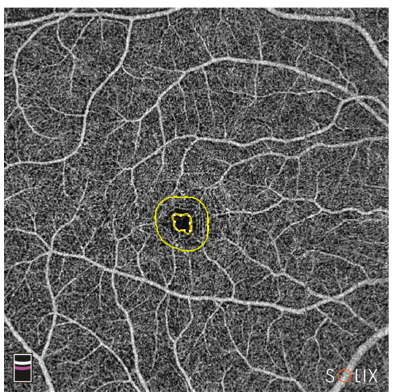
Figure 3. Overview of the optical coherence tomography angiography (OCTA) centered on the fovea. Retinal layer segmentation was automatically performed using the OCTA device and manually reviewed and corrected where necessary. ( A ) En-face image of superficial capillary plexus (SCP) ( B ) En-face image of deep capillary plexus (DCP) ( C ) Cross-sectional OCT B scan centered on the fovea, with segmentation of the SCP. Red line represents upper limit of slab = ILM; green line represents lower limit = IPL − 10 µm [29]. ( D ) Cross-sectional OCT B scan centered on the fovea, with segmentation of the DCP. Green line represents upper limit of slab = IPL − 10 µm; red line represents lower limit = OPL + 10 µm; Legend : ILM, internal limiting membrane; IPL, inner plexiform layer; OPL, outer plexiform layer.